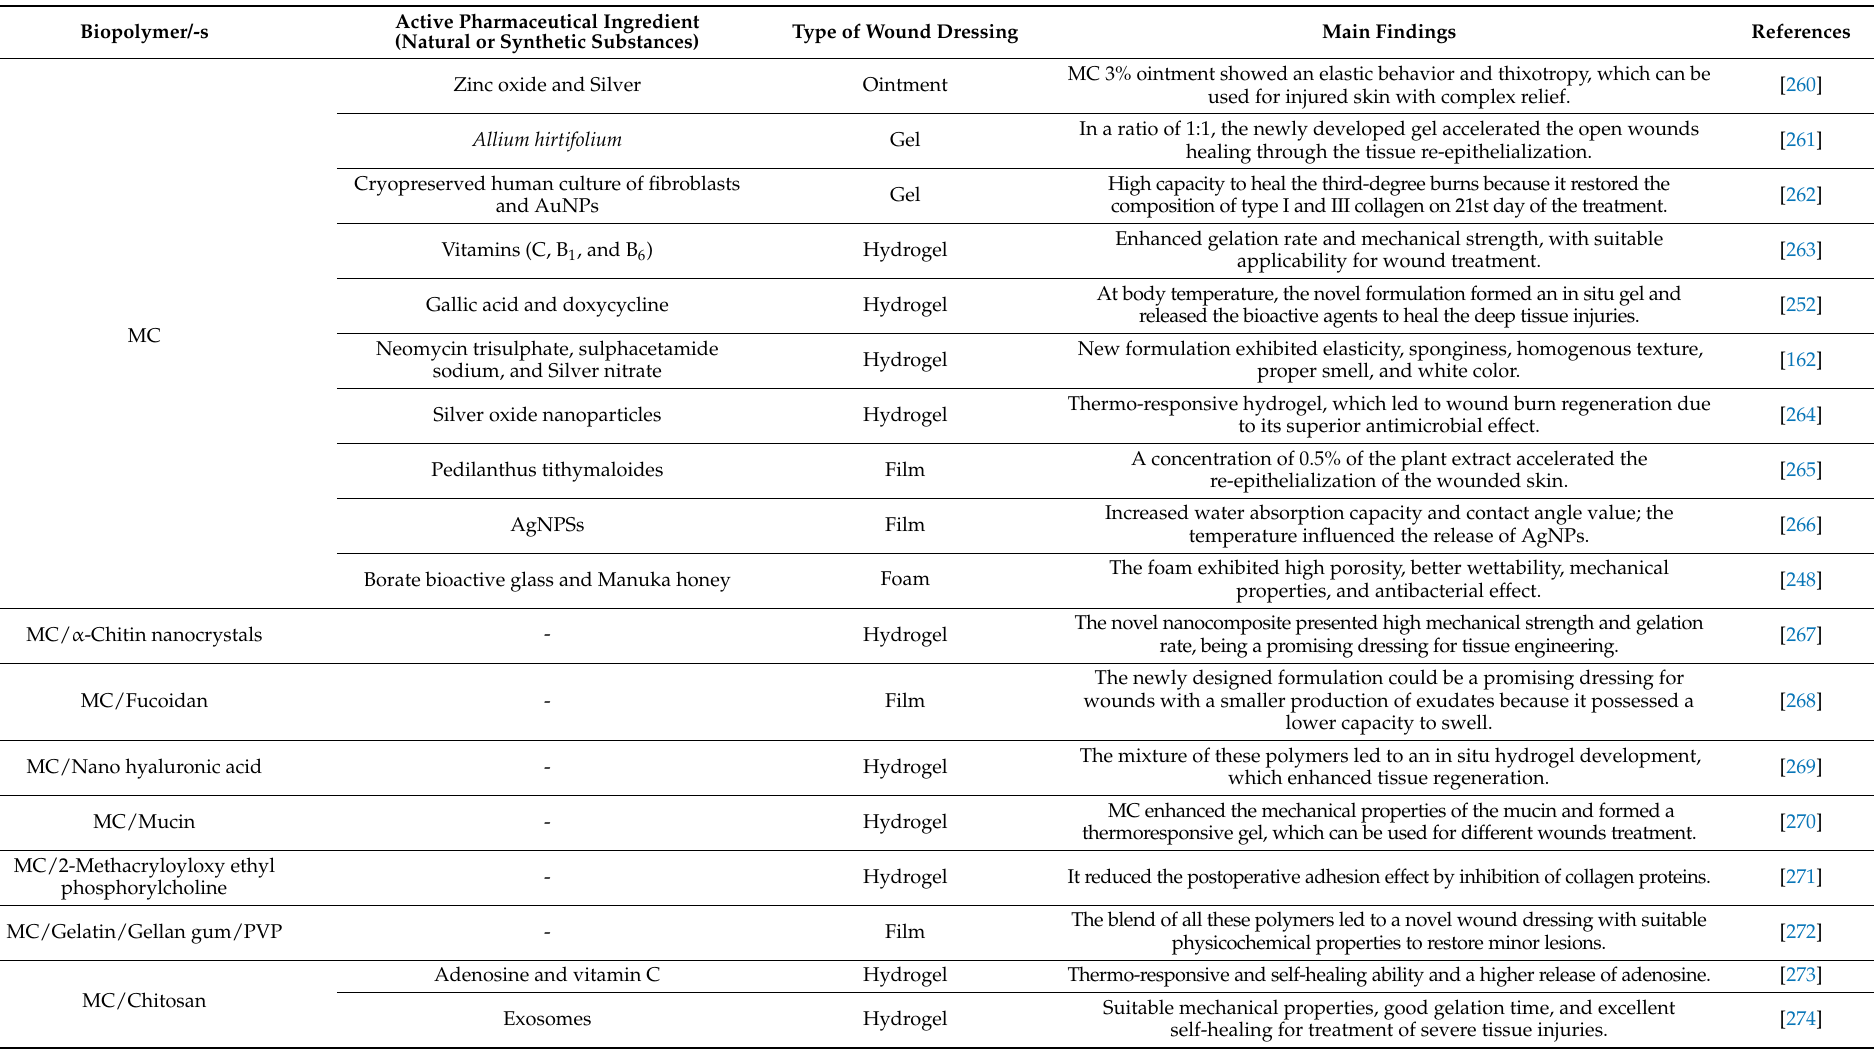
Table 5. Recent studies on the use of methylcellulose as a wound